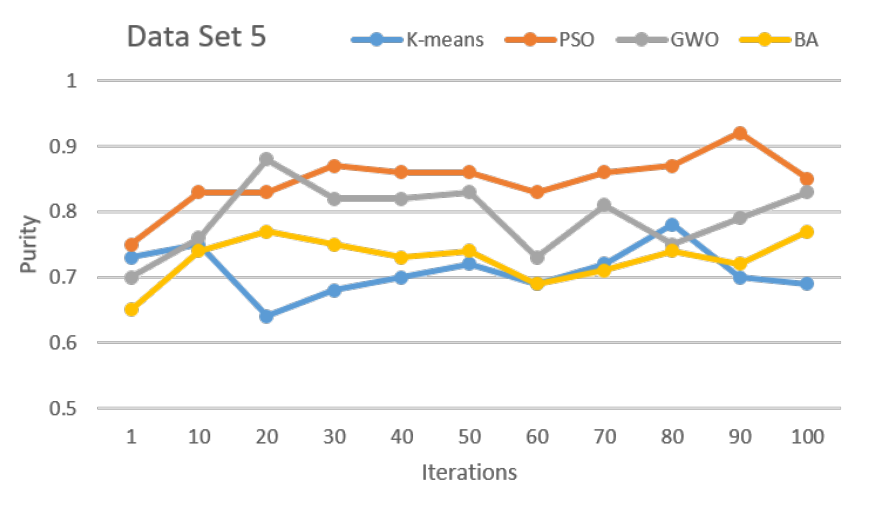
Figure 5. Purity comparison for data set 4.